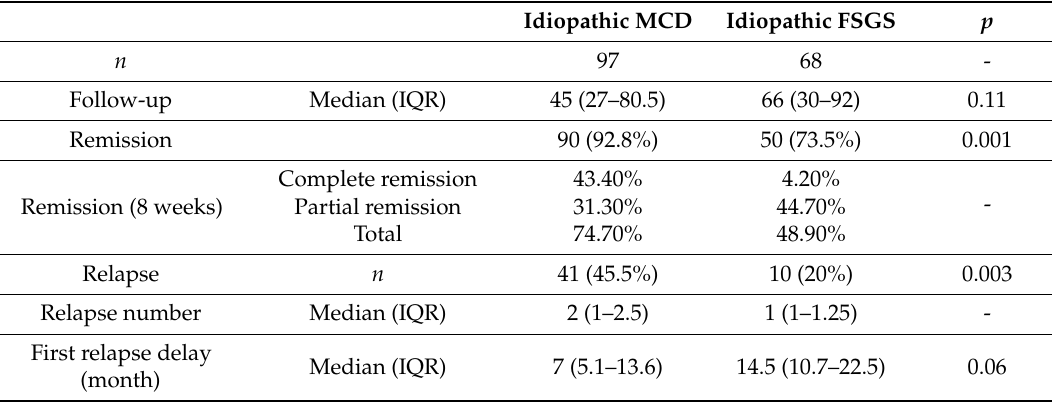
Table 3. Remission and relapse in patients suffering from MCD or FSGS.